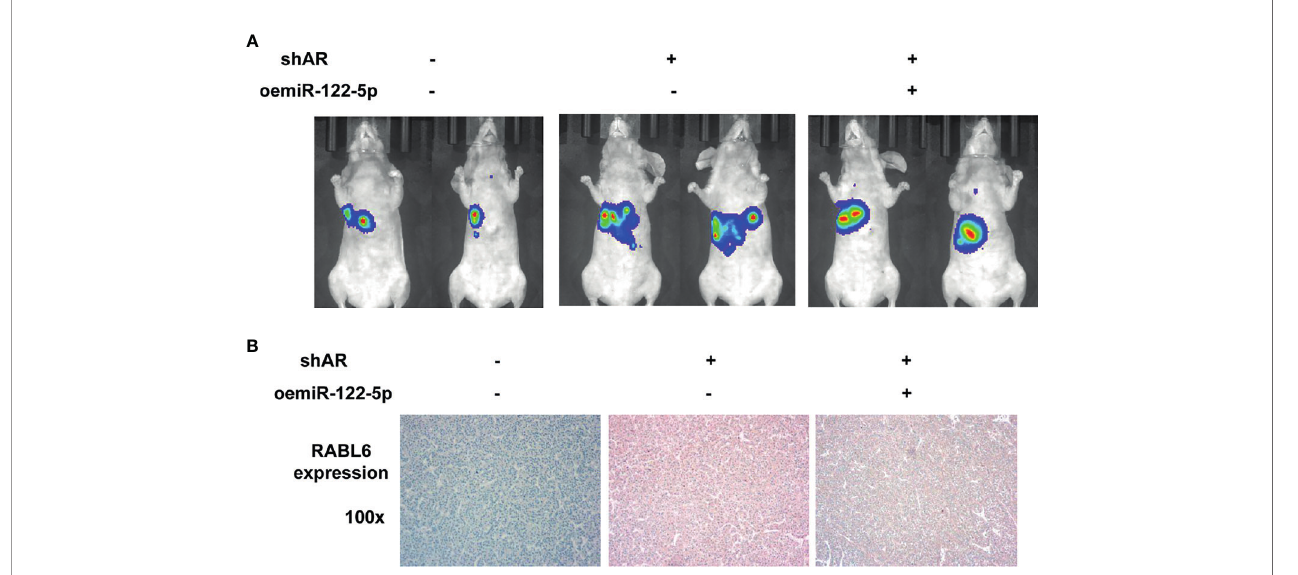
FIGURE 6 | Preclinical study using in vivo mouse model to test the role of AR/miR-122-5p/RABL6 in HCC cell progression. (A) IVIS imaging was used to detect the various distal metastasis foci in mice with orthotopically xenografted tumor cells under the left lobes of the liver capsule. Two representative mouse IVIS bioluminescent images are shown for each group. (B) Representative images of IHC staining for RABL6 in the three groups of mice at ×100 magni fi